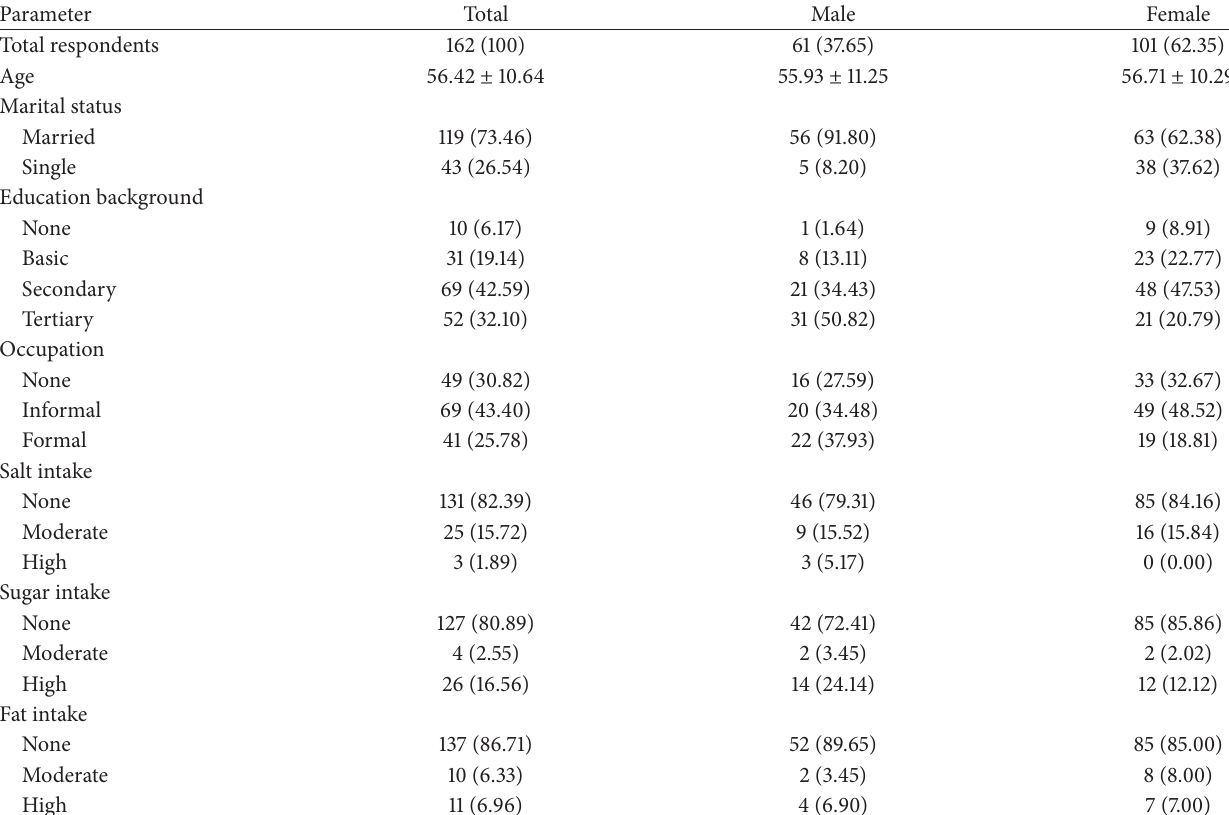
Table 1: Sociodemographic characteristics of the population under study stratified by gender.